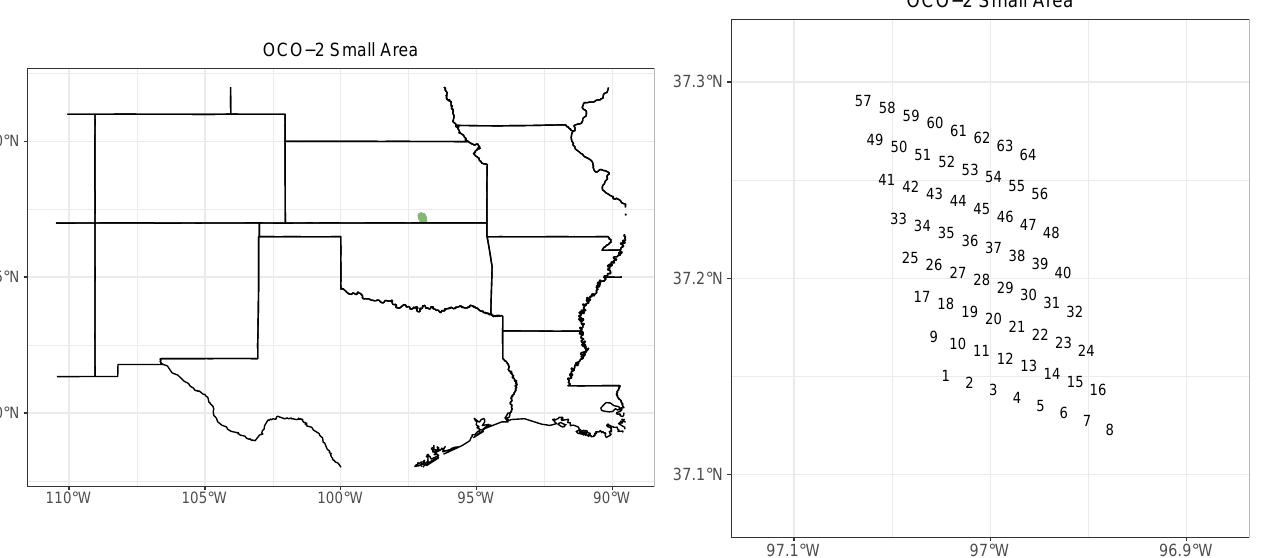
Figure 1. Left : Portion of an Orbiting Carbon Observatory-2 (OCO-2) orbit representing a small area for which a spatial retrieval is investigated. The area in green represents the small area. Right : Zoomed-in view of the locations of the centers of n = 64 individual footprints for the small